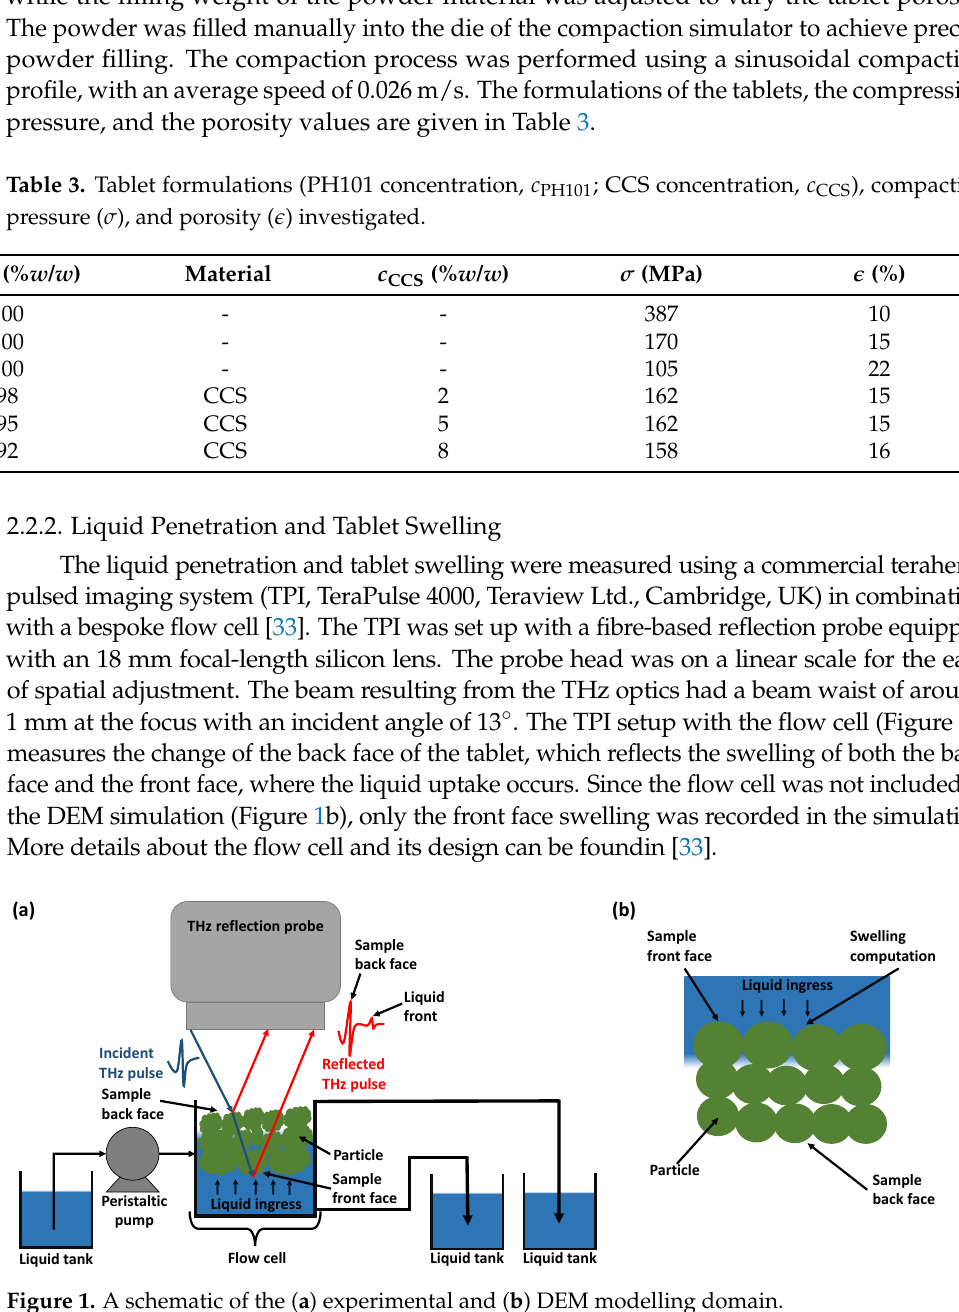
Figure 1. A schematic of the ( a ) experimental and ( b ) DEM modelling